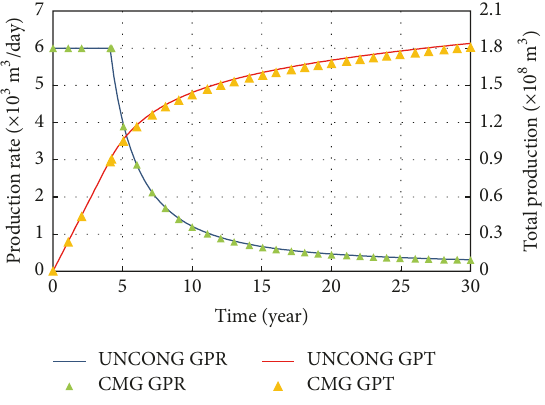
Figure 2: Comparison results of UNCONG and CMG.